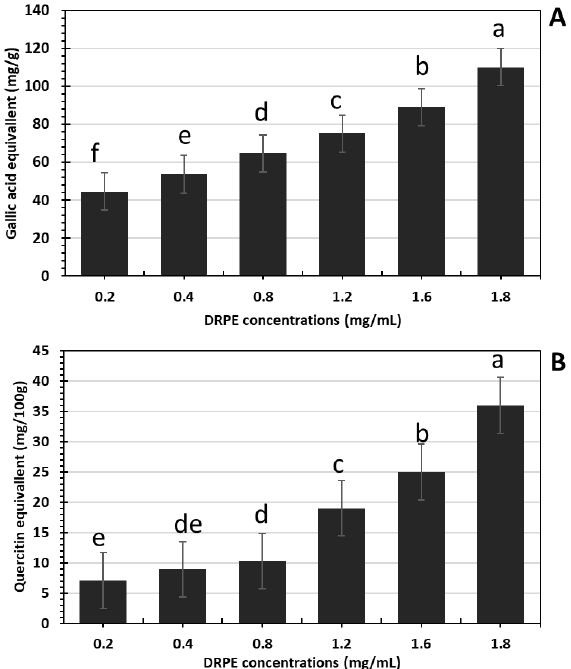
Figure 1. ( A ) Phenolic compounds and ( B ) flavaniods content of DRPE expressed as gallic acid and quercetin equivalents, respectively. Lowercase letters above the columns indicate significant differ- ences.